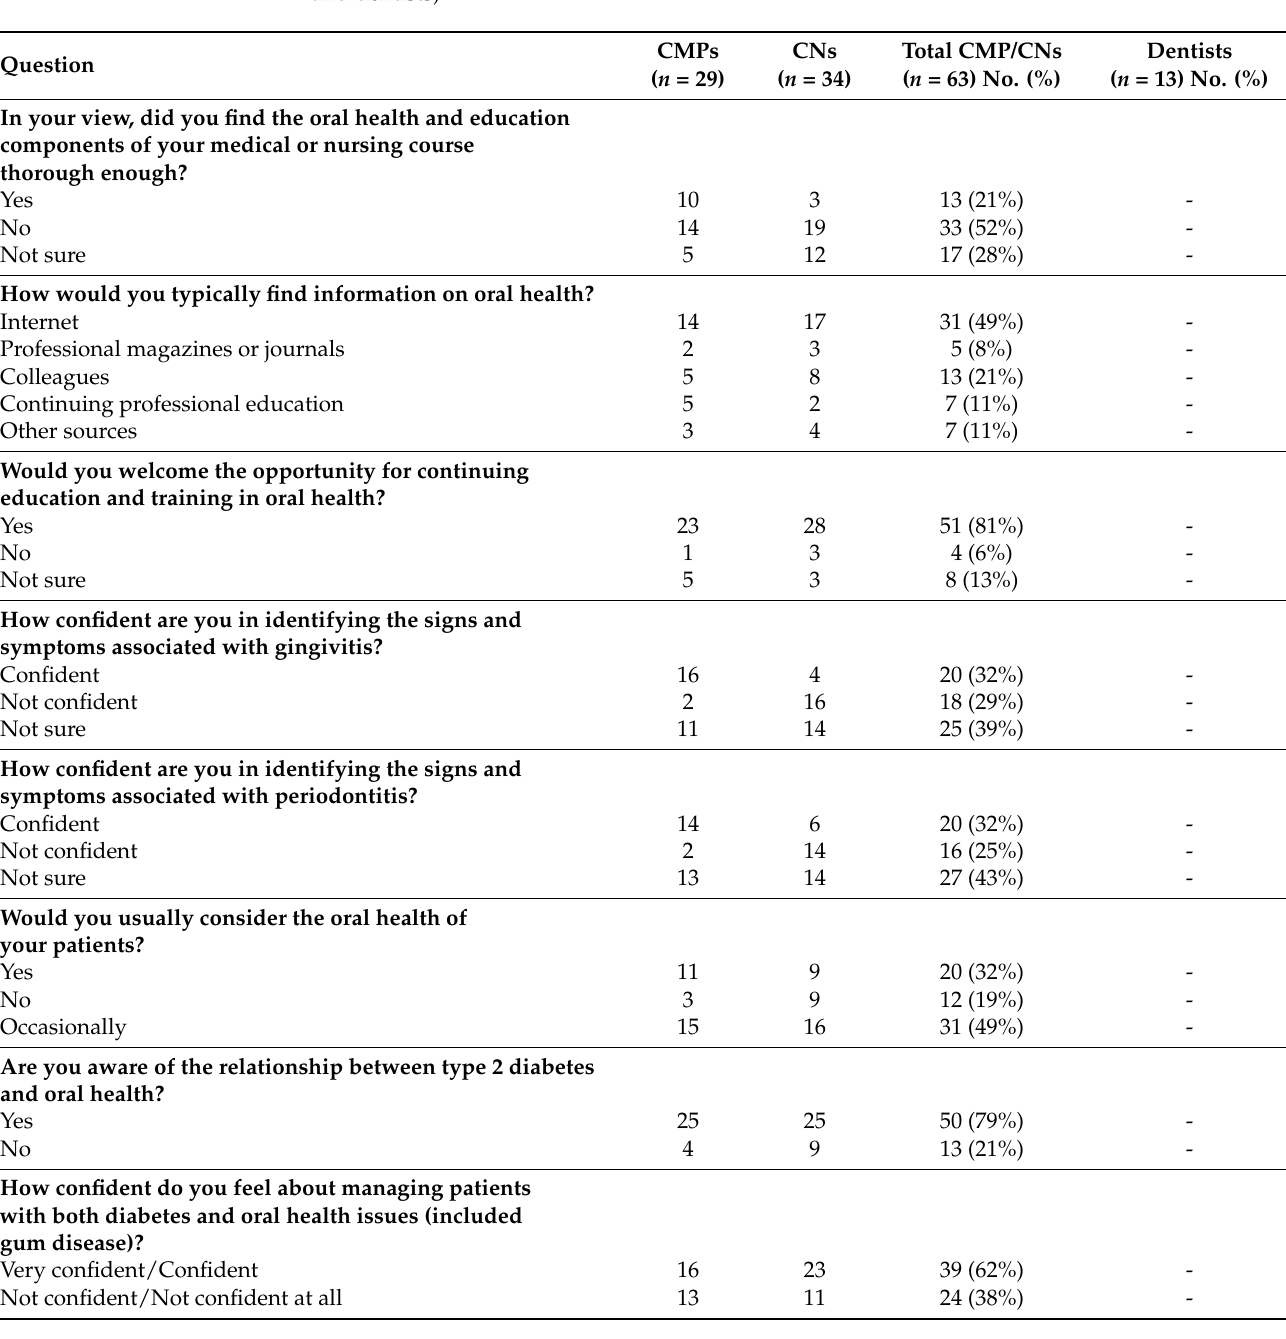
Table 3. Participant responses to questions regarding oral health training, either confidence in di- abetes, oral health, or combined management, referrals, and interprofessional care of diabetes and periodontitis (community medical practitioners (CMPs), community health nurses (CNs) and